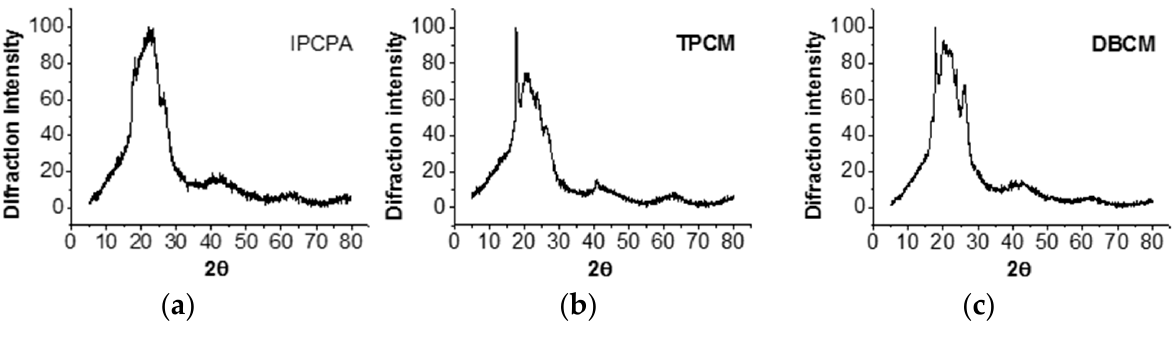
Figure 4. XRD of ( a ) IPCP-A, ( b ) TPCM, and ( c ) DBCM. With these results, the average molecular interchain spacing (< R >) can be approxi- mated for amorphous regions, using the equation: < R > = 5/8( λ /sin θ max ), where θ max is the maximum of the X-ray diffraction. The average distance of the polymer chains in the amor- phous regions was 4.97, 5.29, and 5.35 Å for IPCP-A, TPCM, and DBCM, respectively. These distances are higher than for commercial poly( m -phenylene isophthalamide—4.69 Å) [25], as a result of the introduction of flexible domains, resulting in lower interchain interactions. The surface of the films was also characterized with AFM, RAMAN, and FTIR spec- troscopy (Figure 5). FTIR and Raman spectra confirm the structure of the polymers. Bands around 3300 and 1650 cm − 1 corresponding to N–H stretching and the amide carbonyl absorption, respectively, appear in all the spectra of the polymers. Conjugated double bonds of the aromatic rings agree with the substitution of the –NH–Ar–O– aromatic ring around 1600 and 1500 cm − 1 . The strong band around 1050 cm − 1 is related to the C–O–C vibration of the ether group. Raman bands correspond to prohibited transitions for the infrared spectroscopy, thus showing complementary information. Topography 3D images in the AFM characterization show the soft blocks (black) and harder blocks (yellow). Soft and hard regions appear to be distributed homoge- neously in the surface of the films for all the polymers. The penetration of the AFM tip in the soft regions varied between − 8.59 and 9.18 nm, whereas in hard blocks the tip did not